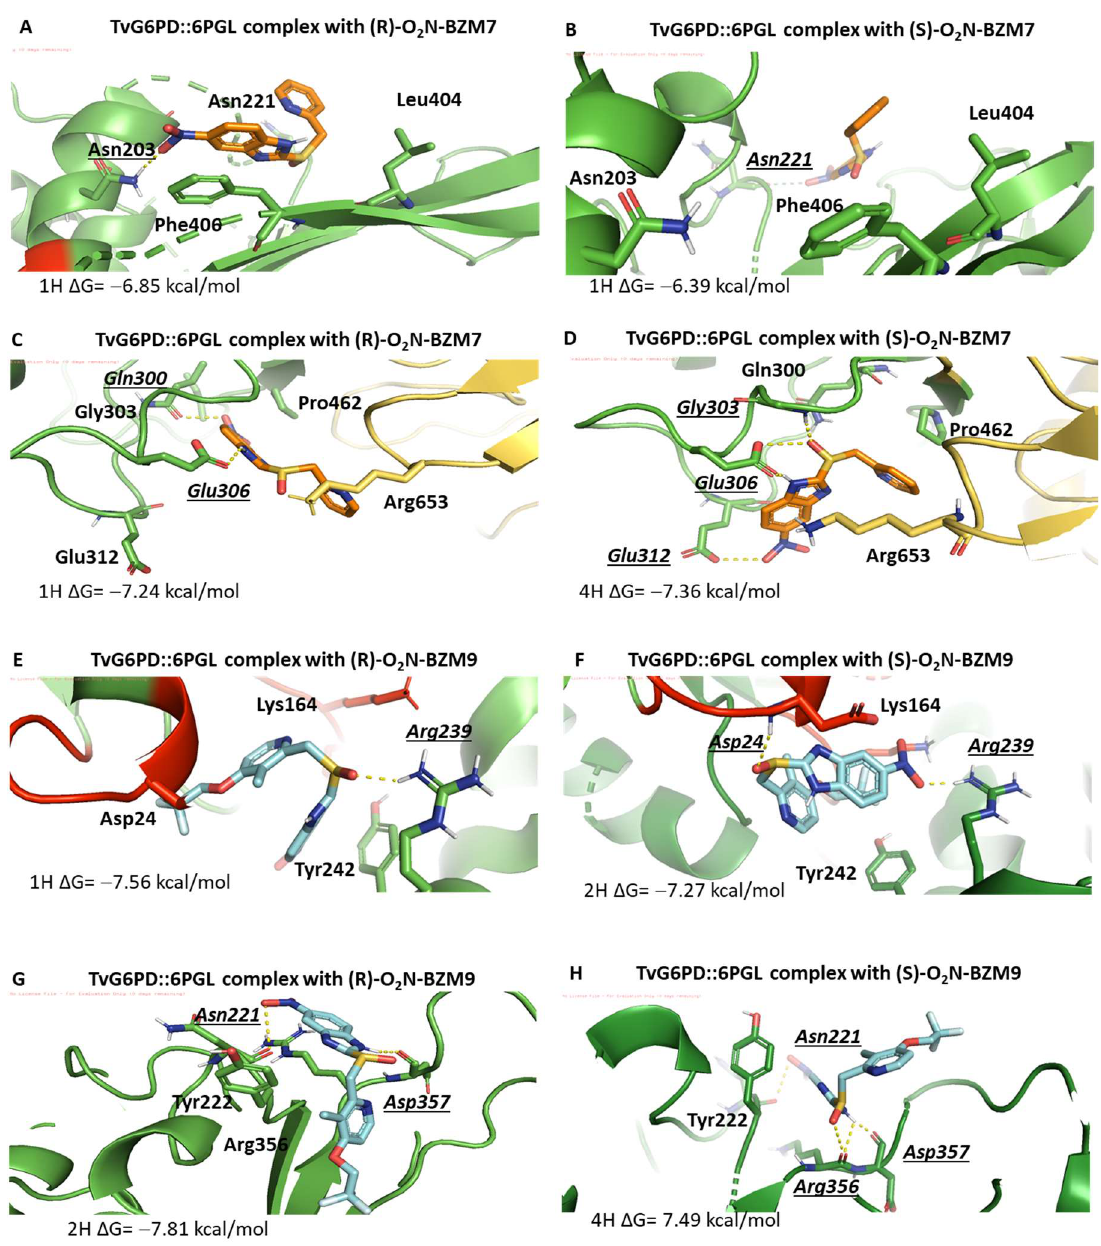
Figure 9. Interaction zones of the chemical compounds O 2 N-BZM7 and O 2 N-BZM9 in the TvG6PD::6PGL protein. ( A ) Interaction zone near the structural NADP + site ( R )- O 2 N-BZM7 , ( B ) ( S )- O 2 N-BZM7, and ( C ) the 6PGL domain of TvG6PD::6PGL with the compound ( R )- O 2 N-BZM7